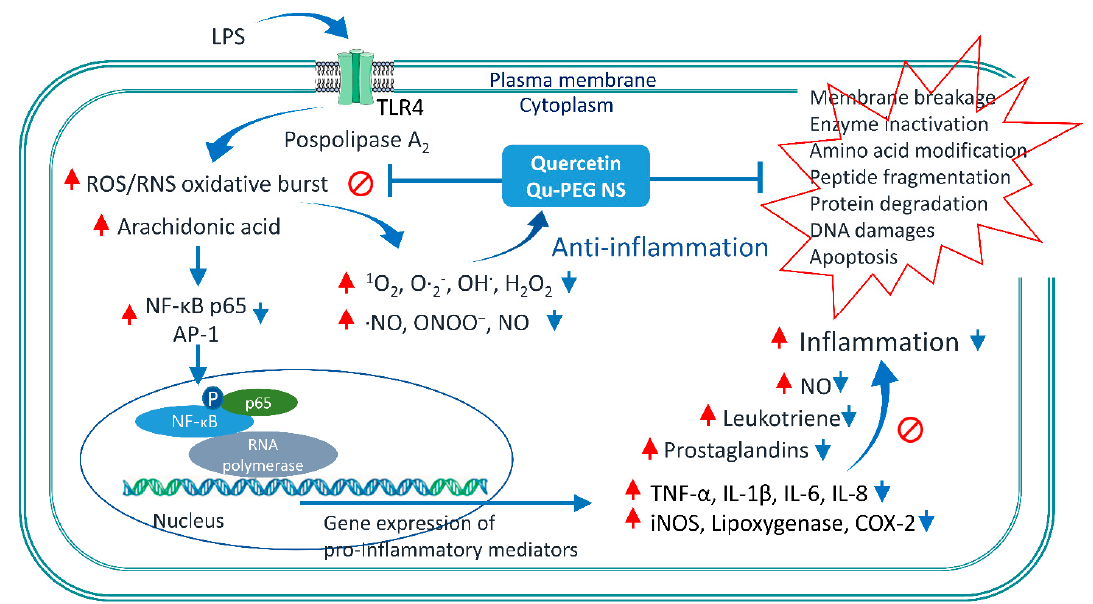
Figure 11. Schematic representation of the mechanism of Qu and Qu-PEG NS anti-inflammation effects in LPS-induced inflammatory RAW 264.7 cells. In this study, the Qu and Qu-PEG NS quench ROS and RNS, which may be responsible for inhibiting the active NF- κ B transcription factor and suppression iNOS, Cox-2, and pro-inflammatory mediator protein levels, including TNF α , IL-1 β , IL-6, and IL-8. Furthermore, the attenuation of NF- κ B activity accompanies the inhibition effects of Qu and Qu-PEG NS by preventing NF- κ B translocation from the cytoplasm to the nucleus. Red arrows indicate for inflammation pathway by LPS. Blue arrows indicate the anti-inflammation pathway by Qu or Qu-PEG NS molecules. Abbreviations: Activator protein 1 (AP-1), Cytochrome c oxidase subunit 2 (COX-2), inducible nitric oxide synthases (iNOS), Interleukin 1 beta (IL-1 β ), Interleukin 6 (IL-6), Interleukin 8 (IL-8) Nuclear factor kappa-light-chain-enhancer of activated B cells (NF- κ B), Nuclear factor NF-kappa-B p65 subunit (NF- κ B p65), reactive nitrogen species (RNS), reactive oxygen species (ROS), toll-like receptor 4 (TLR4), lipopolysaccharide (LPS), tumor necrosis factor alpha (TNF- α ).